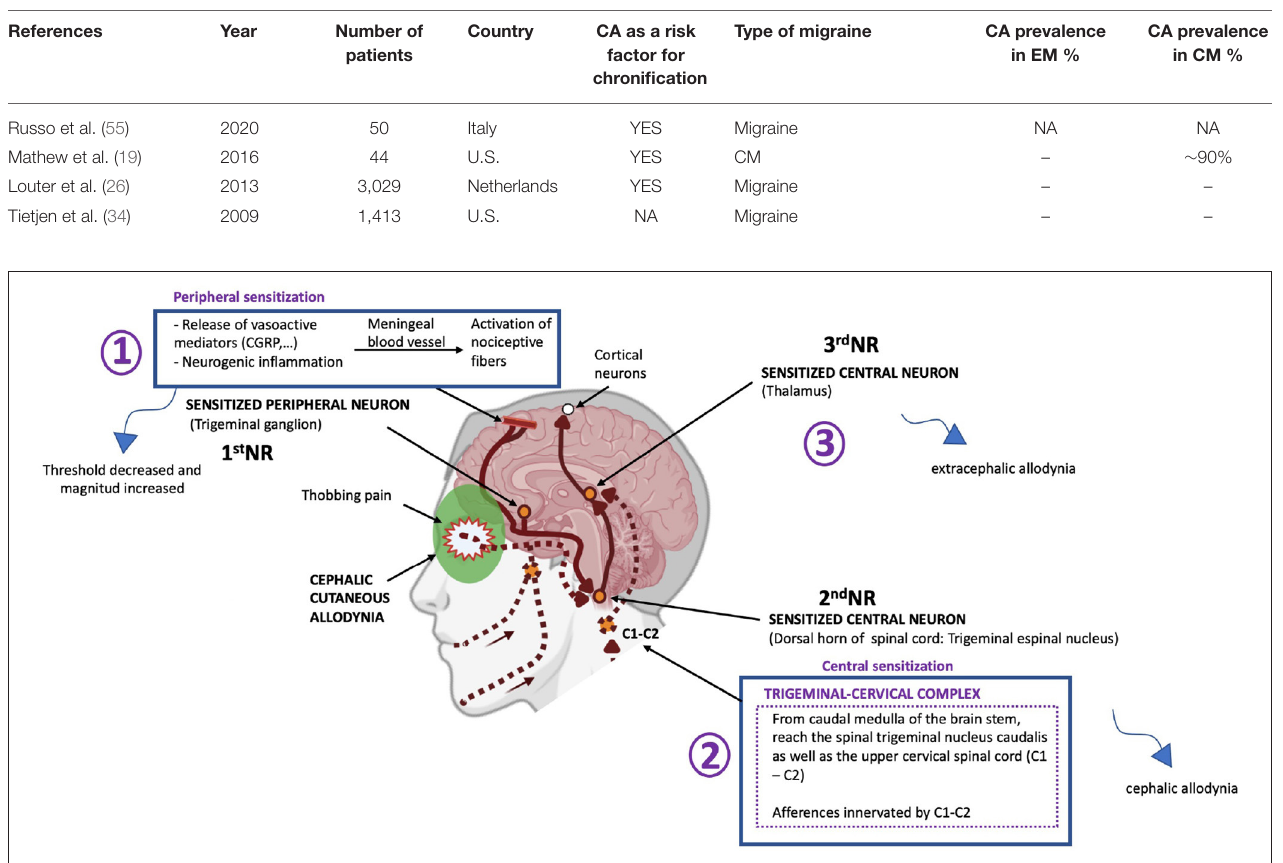
FIGURE 1 | Schematic representation of the sensitization of central trigeminovascular neurons in the thalamus believed to mediate the extracephalic CA trigeminal and nucleus caudalis believed to mediate cephalic CA during migraine. NR, Neuron. Adapted from Noseda and Burstein (72).